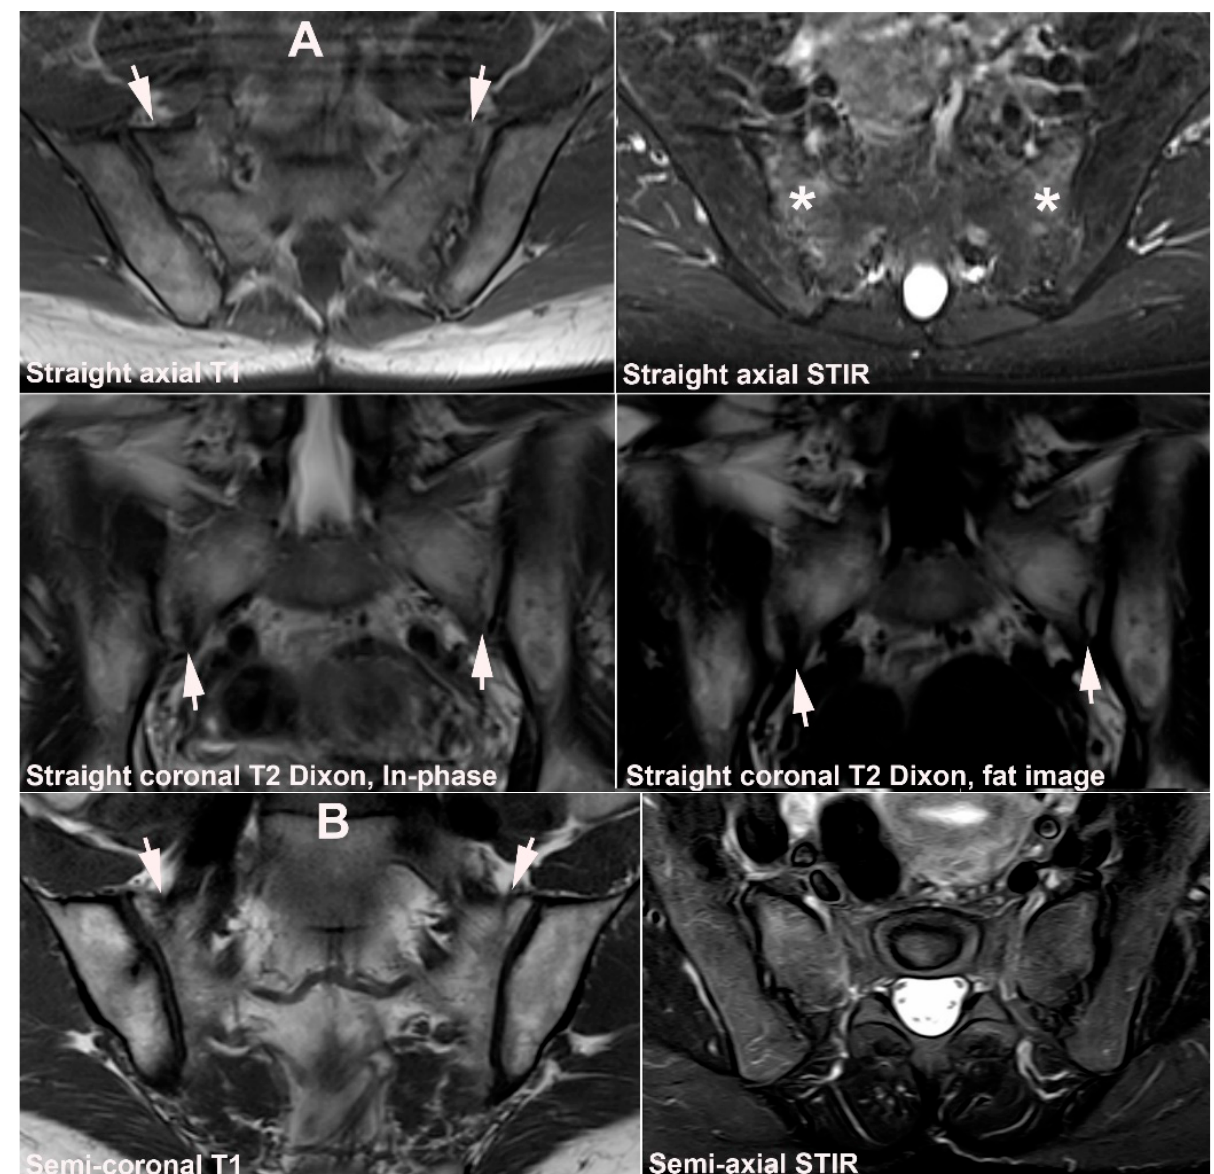
Figure 23. Sacral stress fracture in a patient with osteopenia. ( A ) MRI in a 57-year-old woman with low back pain after jogging, straight axial T1 and STIR, and coronal T2 mDixon with In-phase (T2) and fat image showing diffuse BME in the lateral part of the sacrum reaching the subchondral areas (asterisks) with visible fracture lines in the middle anterior portion of the sacrum on the T1-weighted and the Dixon images (white arrows). ( B ) One month later a dedicated SIJ MRI was performed, semi-coronal T1 and semi-axial STIR. The BME had regressed, but there was still subchondral edema, especially on the right side, and visible fracture lines on the T1-weighted image (arrows). Subsequent DEXA scanning revealed osteopenia, indicating a combination of sacral stress and insufficiency